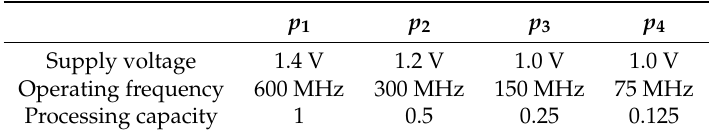
Table 5. Processor properties.